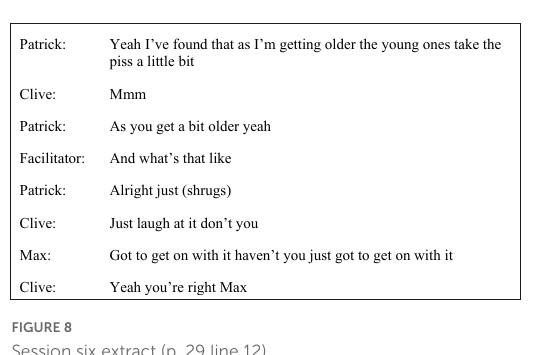
22 line 4) which may also reflect distraction from the session.